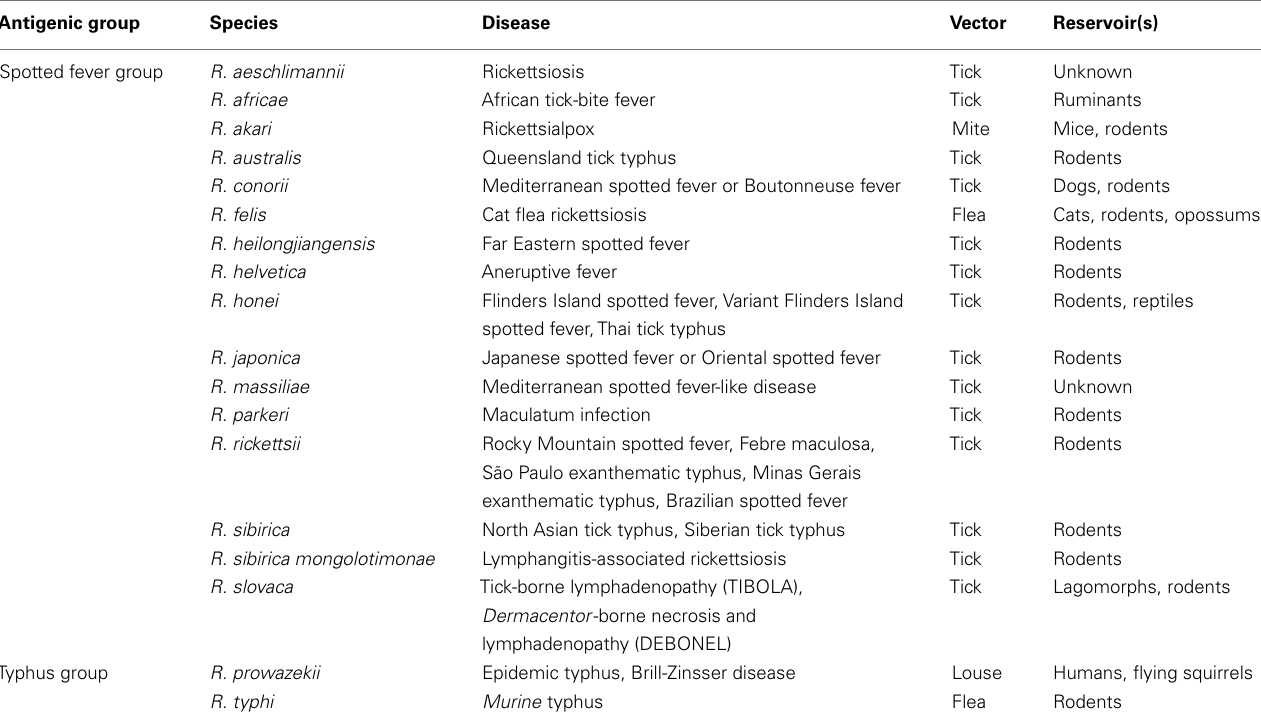
Table 1 | Classifications, vectors, and reservoirs of Rickettsia that are known to be pathogenic to humans. Antigenic group Species Reservoir(s) Spotted fever